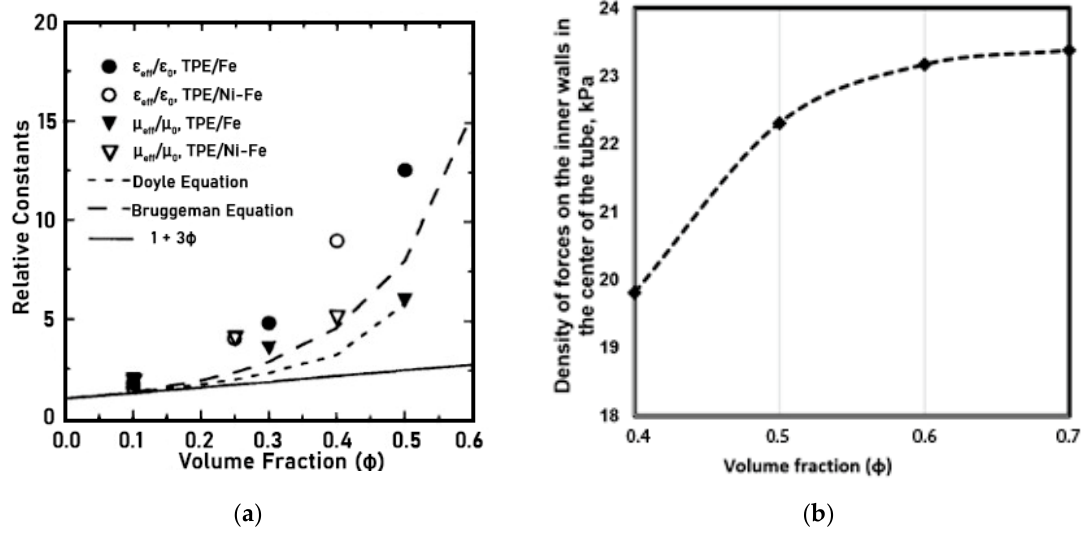
Figure 1. Properties of the MAEs as a function of the filler content: ( a ) the dependence of the dielectric constant; ( b ) the dependence of the distribution of pressure (magnetic attraction) in the tube.